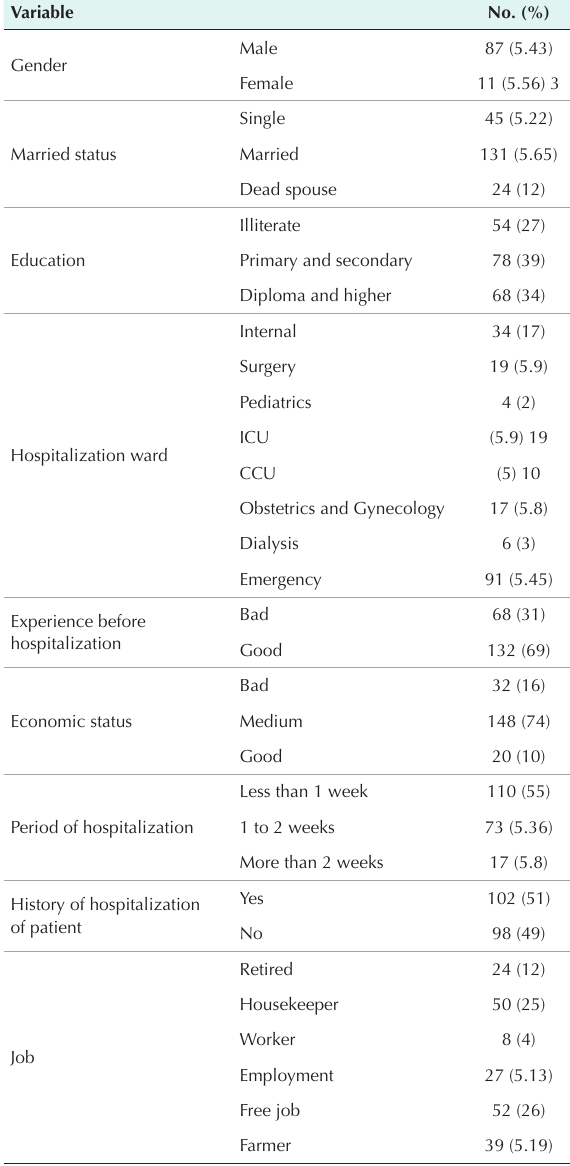
Table 1. Demographic Characteristics of Patients Participating in the Study